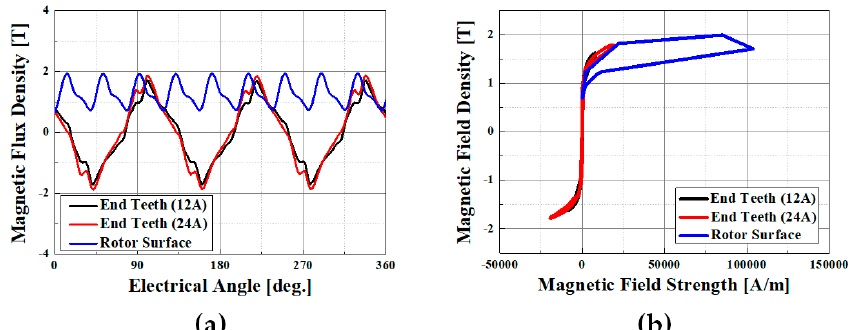
Figure 6. ( a ) End teeth flux density with 12 and 24 A peak phase current input conditions in the time frame. V shape inner permanent magnet rotor surface flux density. ( b ) Comparison of B-H Loops of end teeth and rotor surface.